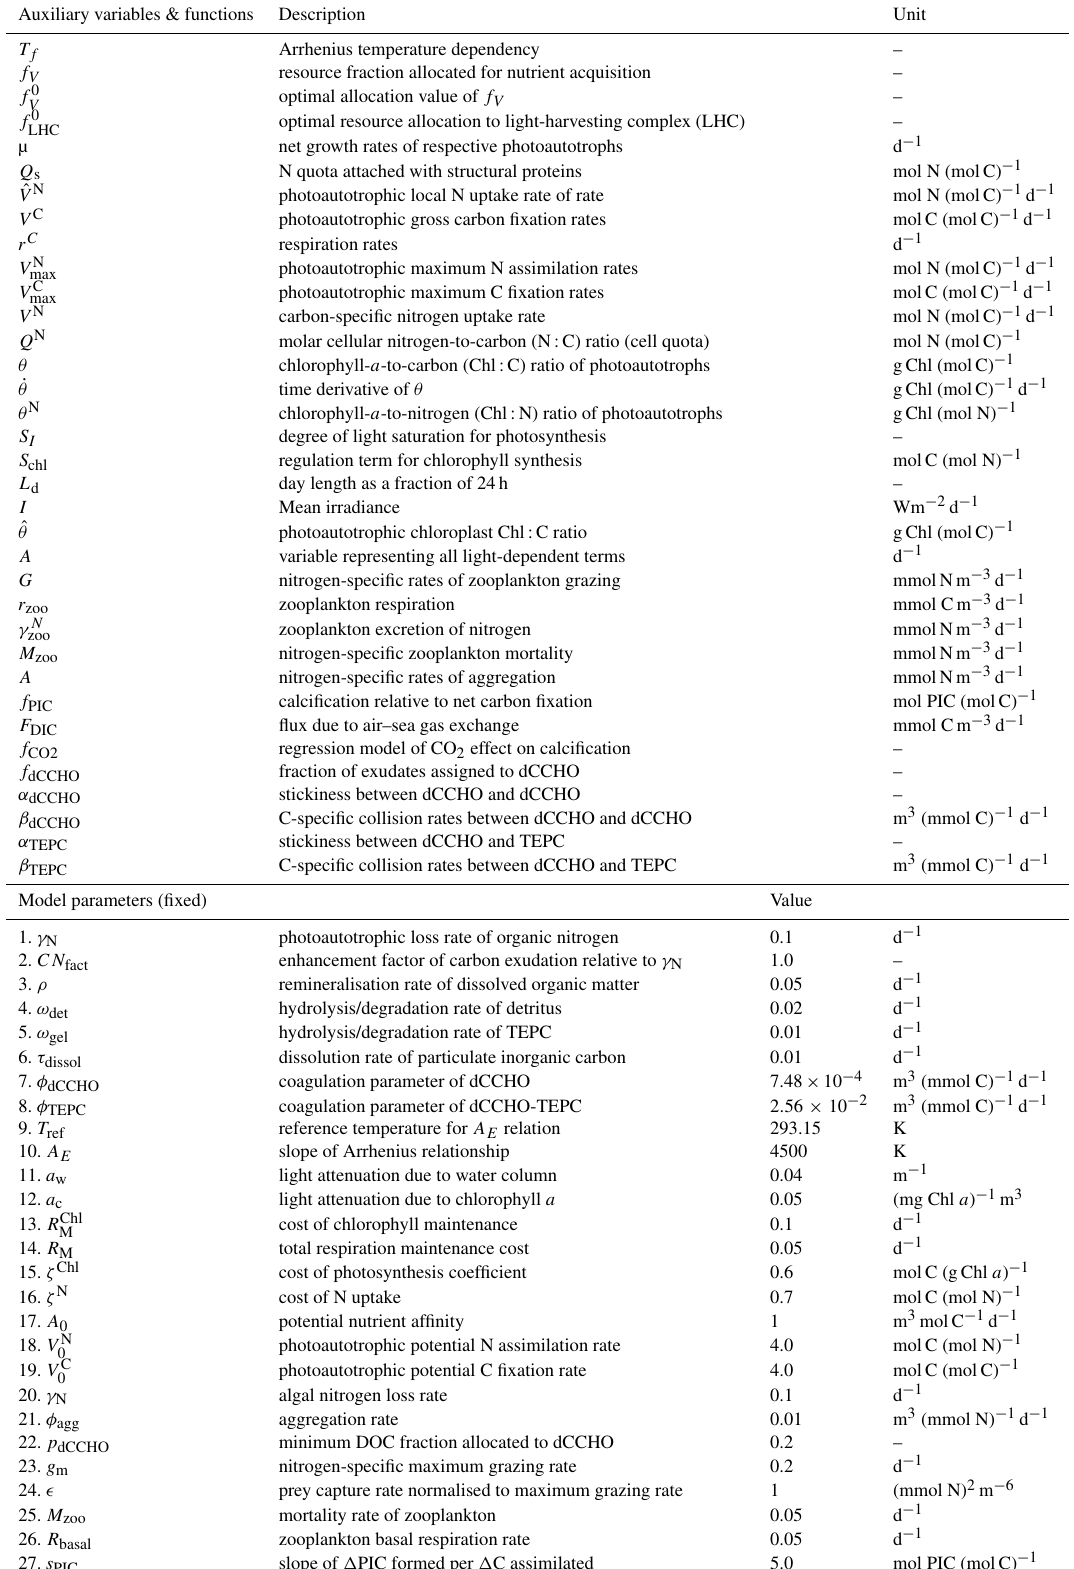
Table A1. Auxiliary model variables and model parameters. Auxiliary variables & functions